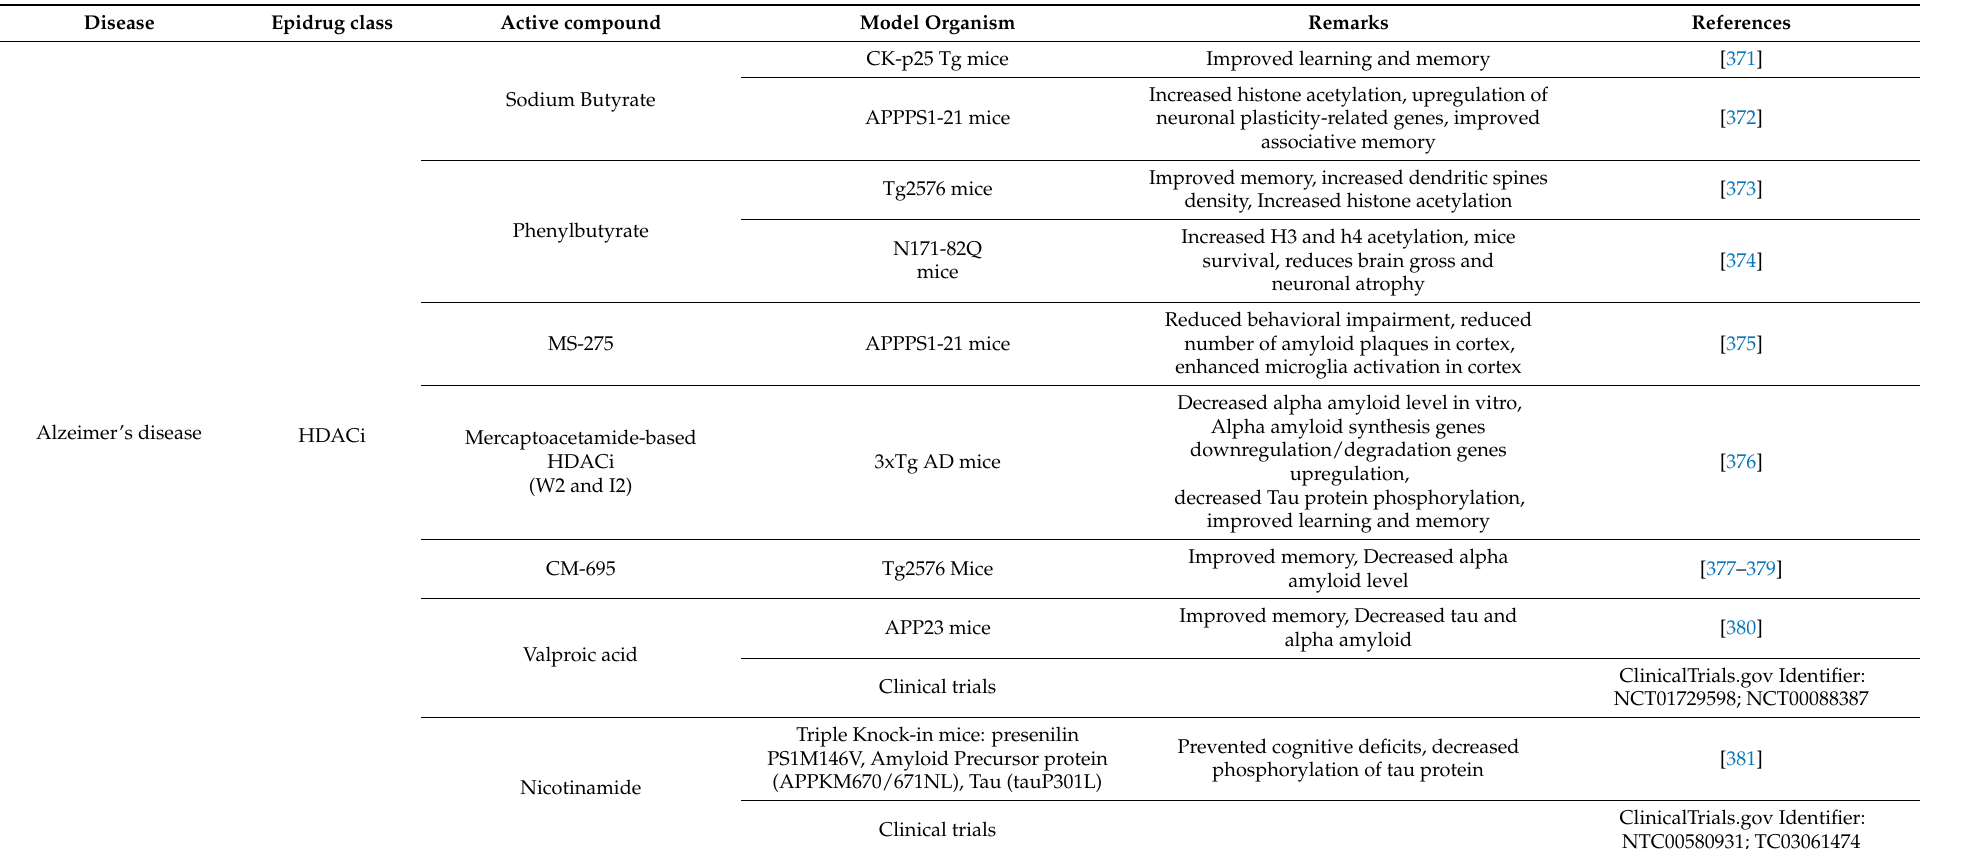
Table 2. Epidrugs in NDs